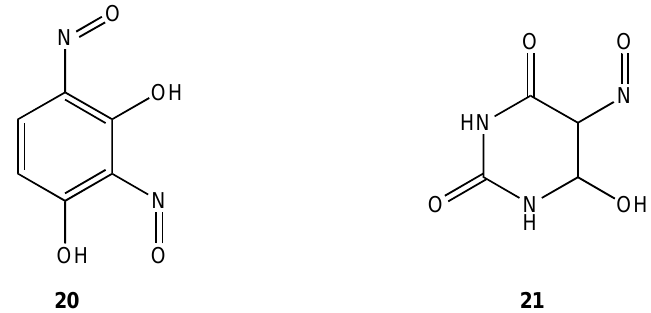
Figure 12. Dinitrosoresorcinol and violuric acid